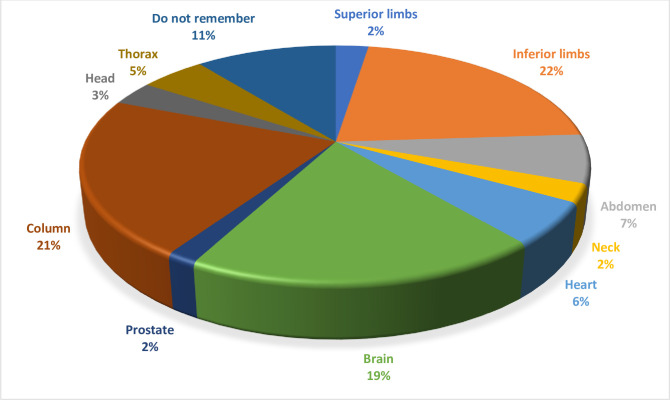
Sites of MRI scan request.